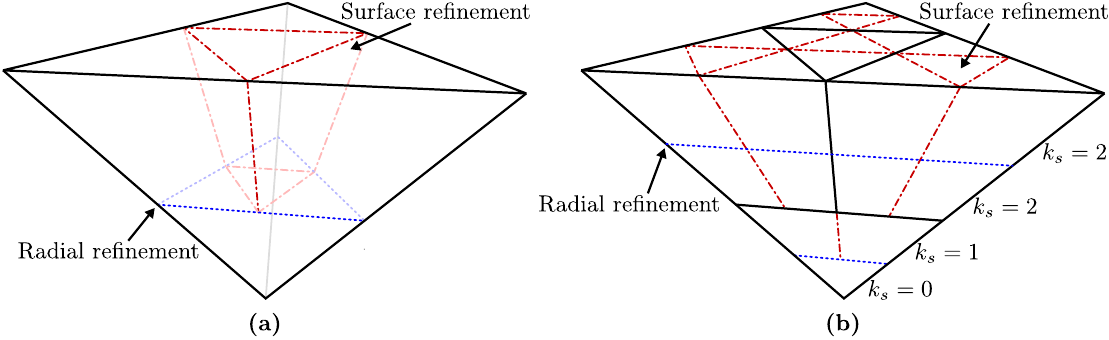
Figure 5. Semiregular prismatoid refinement as applied to a single pyramid cell ( a ) once and ( b ) twice. In ( b ), the number of times the surface refinement has been applied ( k s ) is shown for each layer; see how the radial refinements of central layers separate regions of the grid with different values of k s